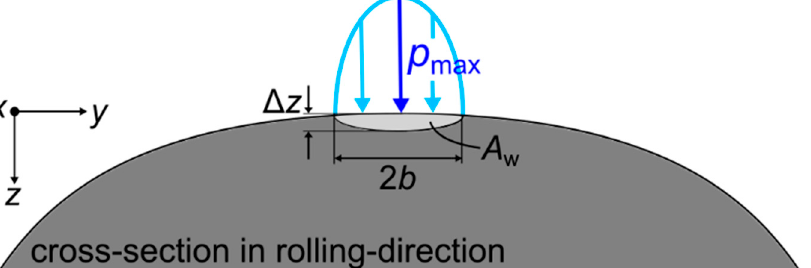
Figure 6. Relation between wear depth ( Δ z ) calculated for the 2D cut containing ( p max ) through the contact patch and the wear area ( A w ) in the cross section in the rolling direction.